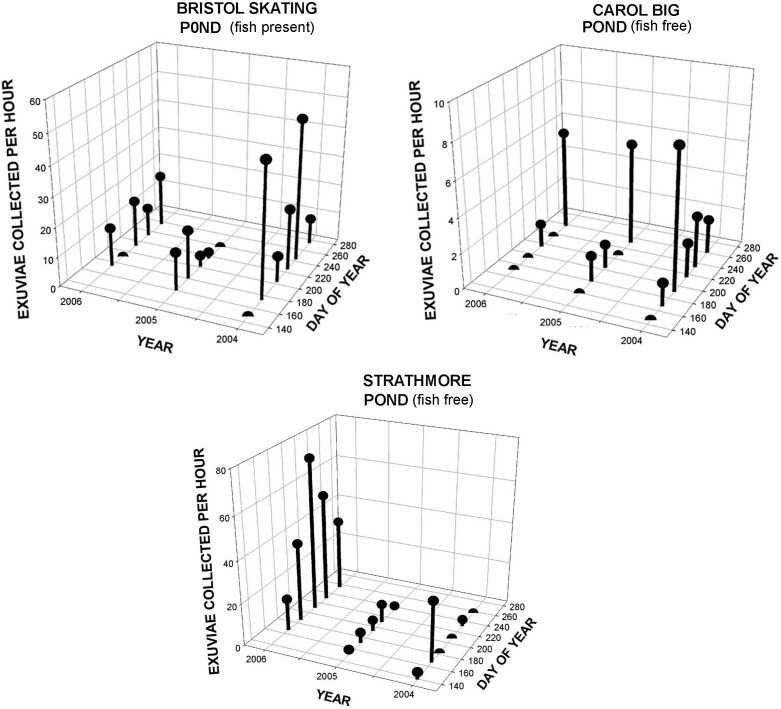
Numbers of Anax junius exuviae collected per hour of effort vs year and day of year at three Rhode Island ponds where collections were made for three years.Only Bristol Skating Pond supported fish; Bristol Skating Pond and Carol Big Pond were dry in August and September 2005, respectively, and Strathmore may have dried in September of that year. Underlying data in S5 Table.